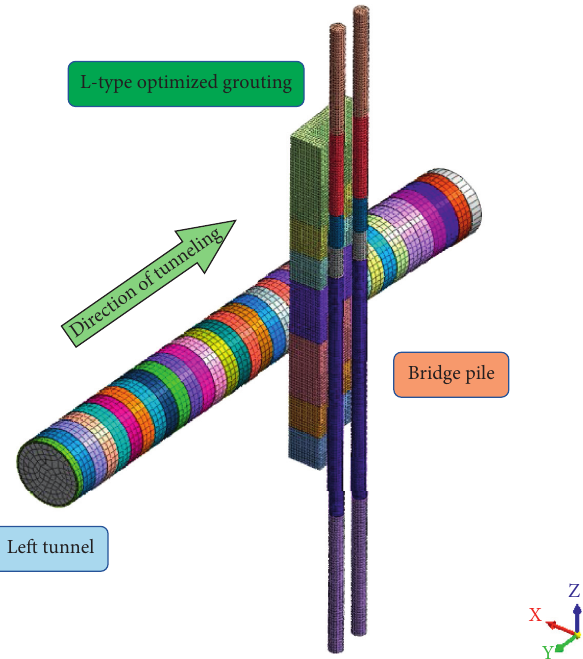
Figure 20: Finite element model of the L-shaped grouting